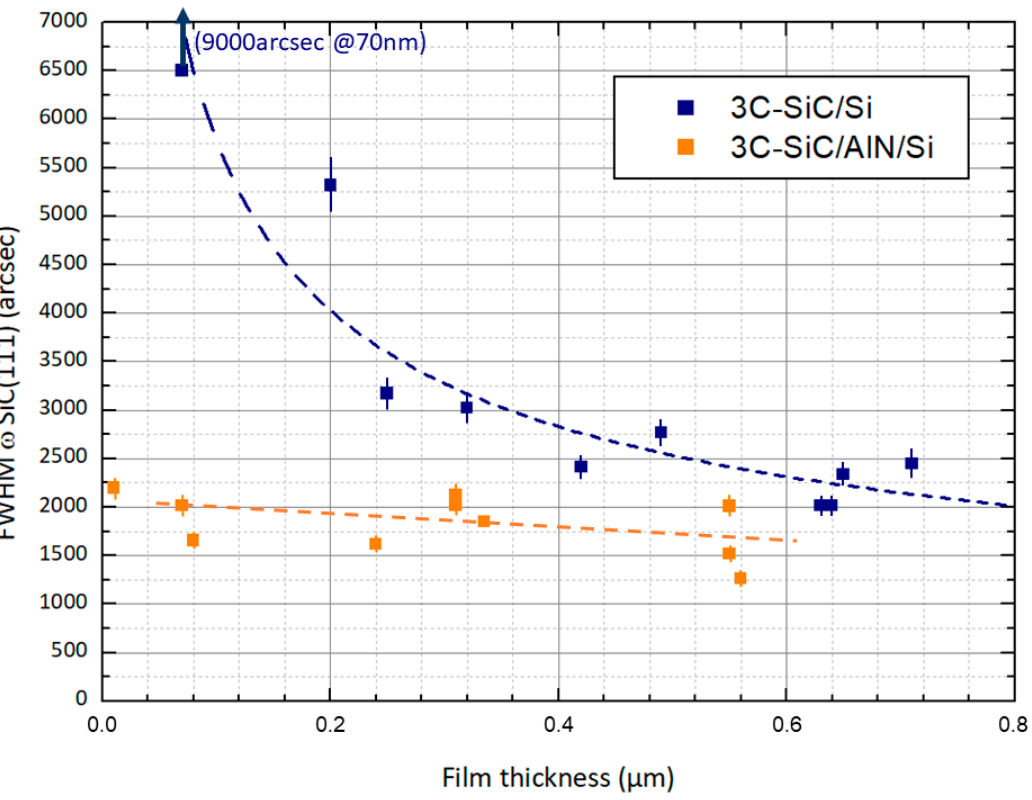
Figure 3. FWHMs recorded on the symmetric SiC(111) diffraction lines for 3C-SiC/AlN/Si (orange) and 3C-SiC/Si (blue) heterostructures. Dotted lines are guides for the eye.